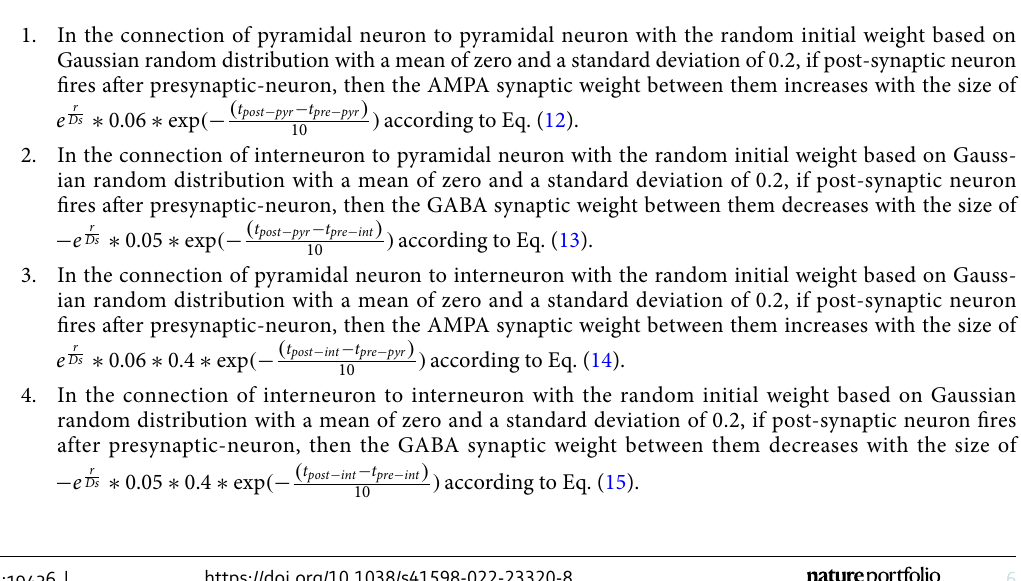
< 0 ) learning rule in the spike-time-dependent-plastisity